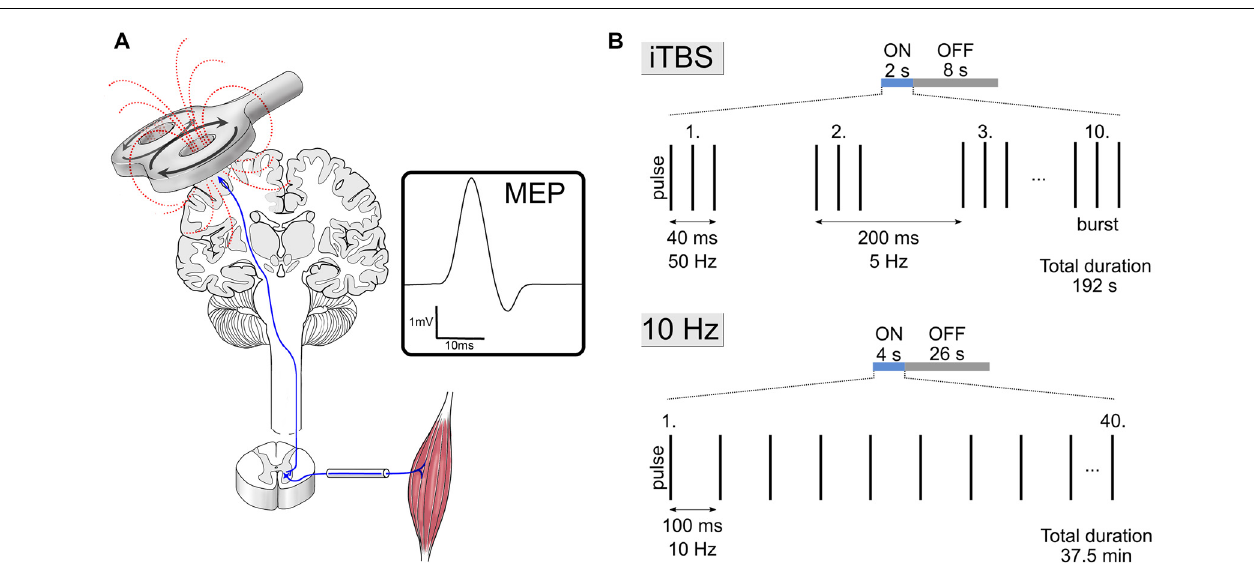
FIGURE 1 | Single-pulse transcranial magnetic stimulation (TMS) and clinically approved stimulation protocols. (A) Visualization of TMS of the motor cortex while recording motor evoked potentials (MEP) of the target muscle. The intensity of TMS is adjusted by recording the amplitude of MEPs elicited from the target muscle while stimulating its motor cortical representation (see Vlachos et al., 2017). (B) Schematic illustration of stimulation parameters of the 10 Hz and intermittent theta-burst stimulation (iTBS) repetitive TMS (rTMS) protocols. Both protocols use stimulation intensities at 120% of the motor